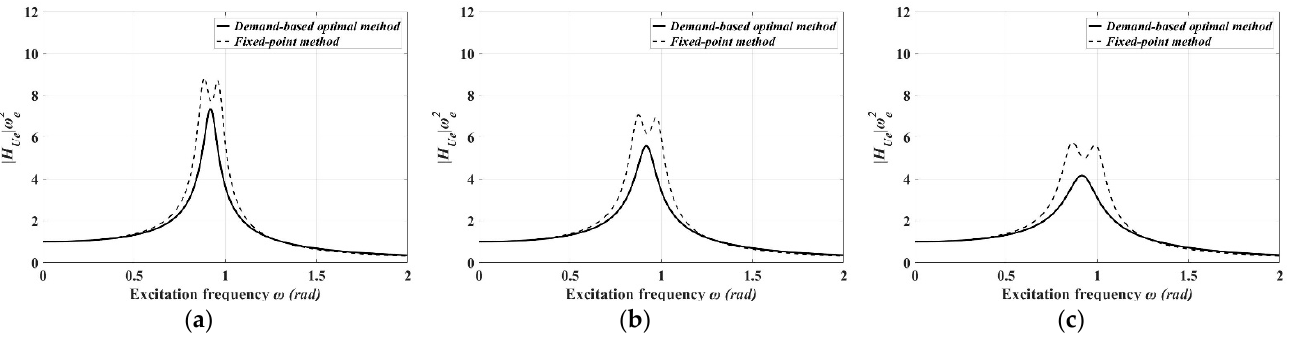
Figure 16. Displacement amplification factor of eaves in SC system: ( a ) γ Ur = 0.7; ( b ) γ Ur = 0.6; and ( c ) γ Ur = 0.5.